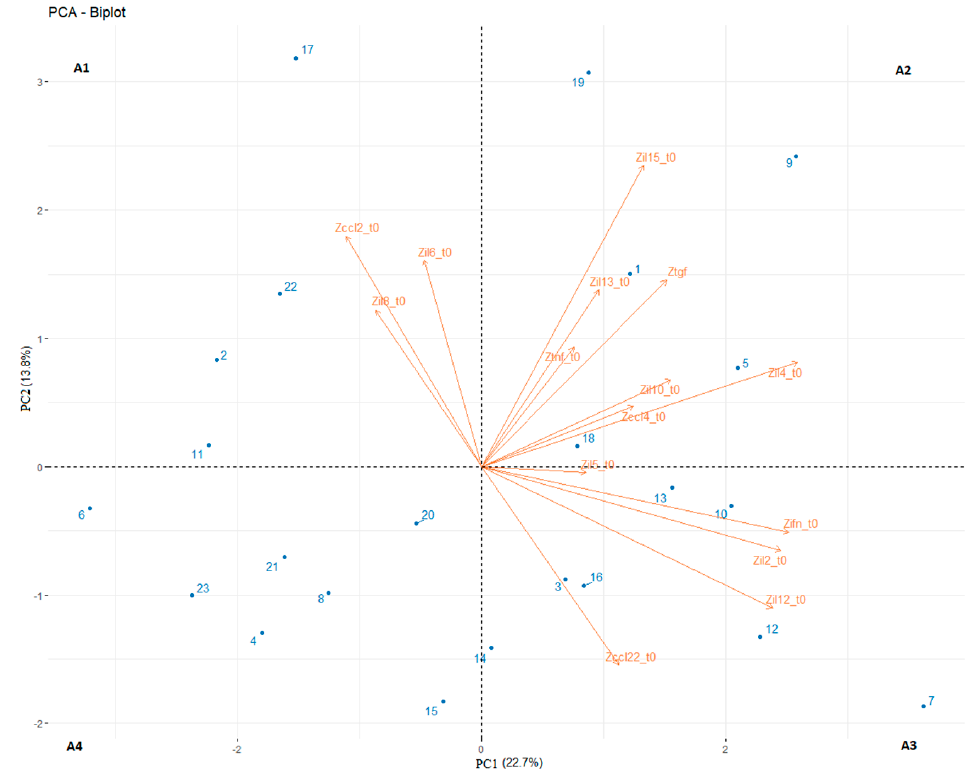
Figure 3. Principle component analysis (PCA) biplot of plasma cytokines (orange vectors) measured at baseline (T0) for all 23 patients (blue dots). In the x- and y-axes are plotted the two principal components (PC1 and PC2). Cytokines values are normalised in z-scores. Every number corresponds to a patient identified in Table 1. Area 1: PC1 < 0 and PC2 > 0; Area 2: PC1 > 0 and PC2 > 0; area 3: PC1 > 0 and PC2 < 0; area 4: PC1 < 0 and PC2 < 0.